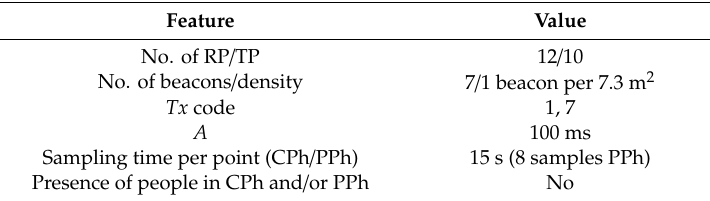
Table 12. Main features of Tests #4.